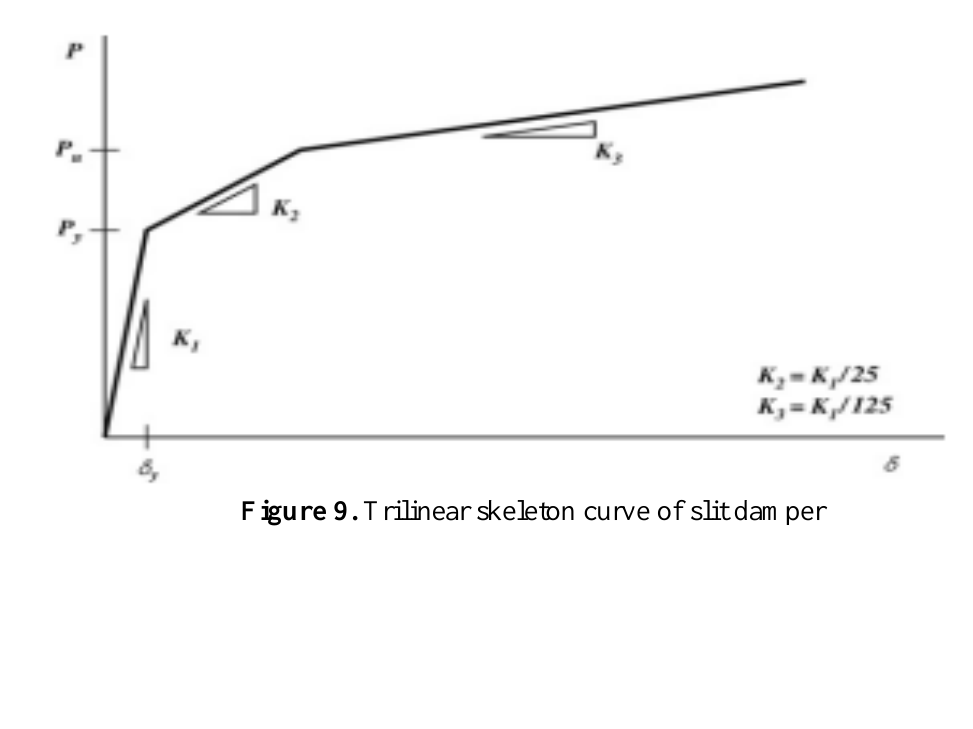
Figure 8. Compression of experiment vs finite element in skeleton curve